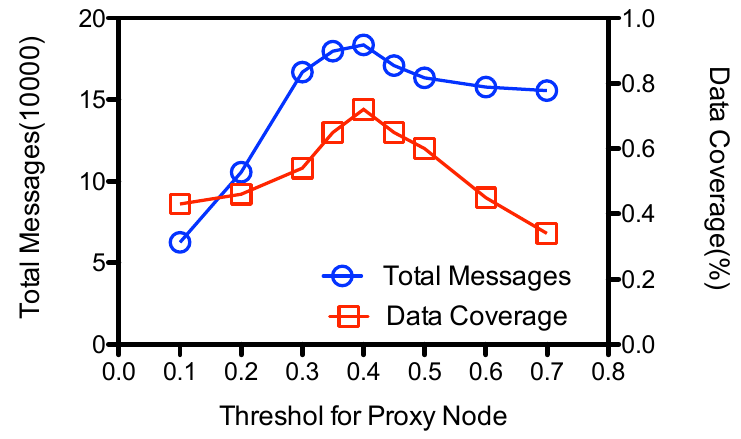
Figure 11. Impact of threshold for proxy node selection( th